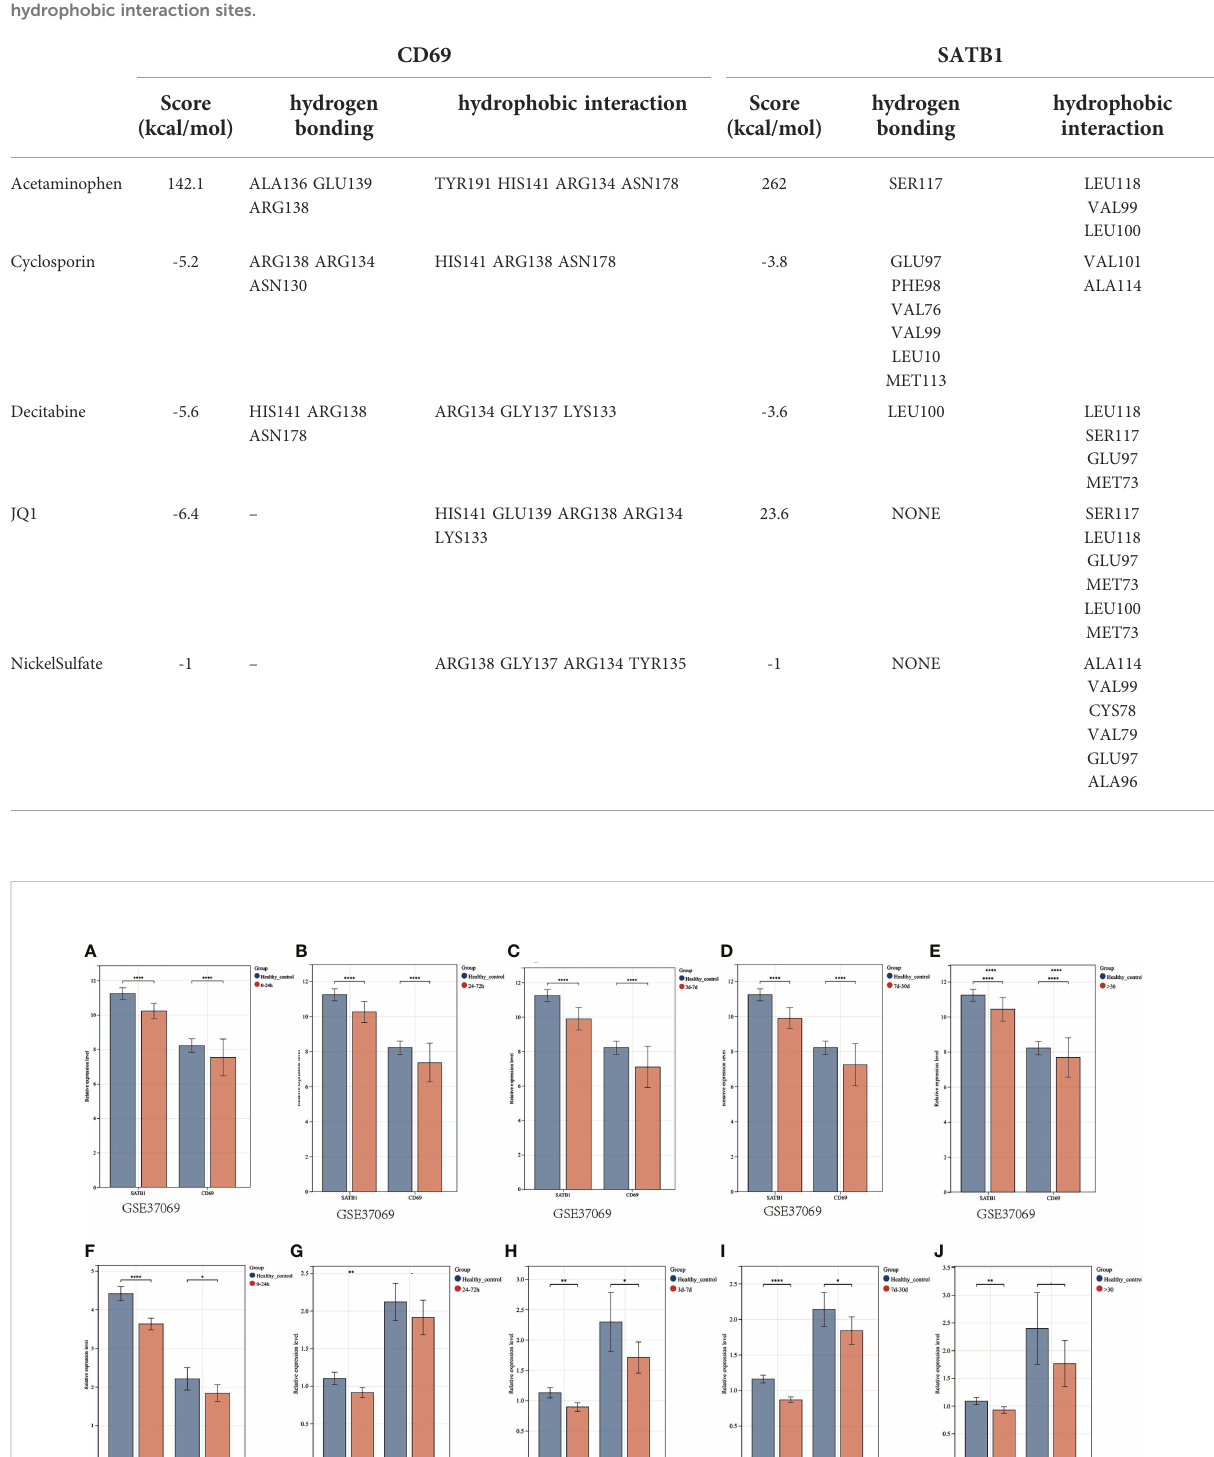
TABLE 3 Main parameters of molecular docking of key genes and compounds, including binding energies and hydrogen bonding and hydrophobic interaction sites.